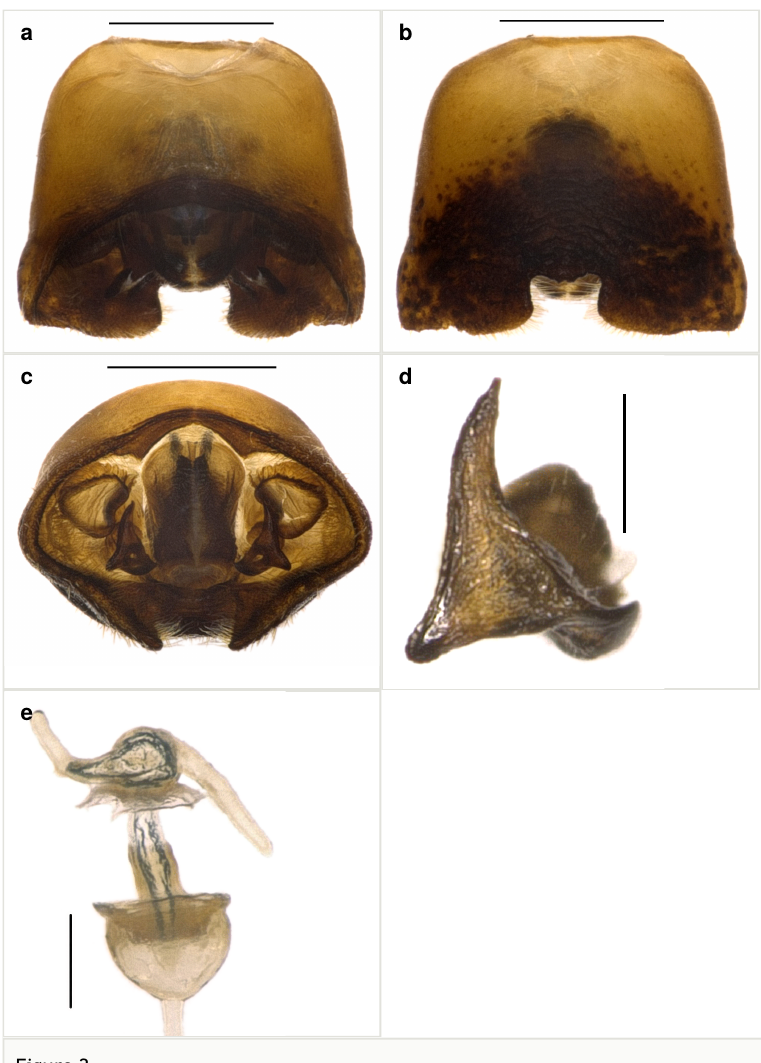
Figure 2. Genitalia of Caystrus orientalis from Japan. a : genital capsule (with parameres and abdominal segment X), dorsal view. Scale bar 1.0 mm. b : genital capsule (with parameres and abdominal segment X), ventral view. Scale bar 1.0 mm. c : genital capsule (with parameres and abdominal segment X), caudal view. Scale bar 1.0 mm. d : left paramere, caudal view. Scale bar 0.2 mm. e : spermatheca. Scale bar 0.2